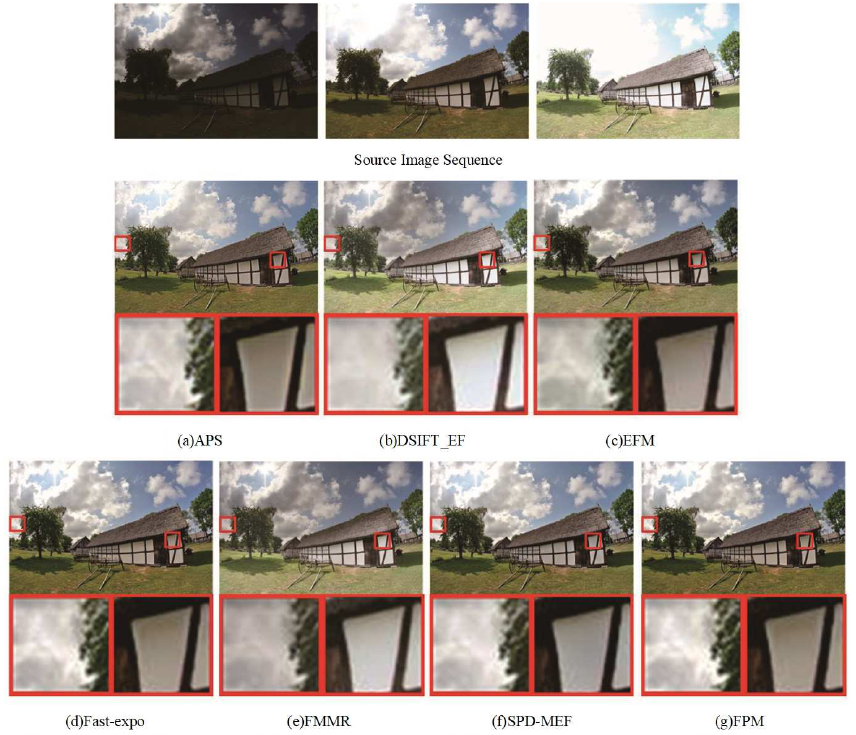
Figure 4. Comparison of the “Kluki” fusion images obtained by the seven fusion methods. ( a ) APS,